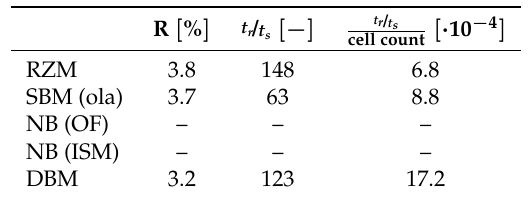
Table 16. Reflection coefficient, normalised run time and normalised run time per cell for the shallow water